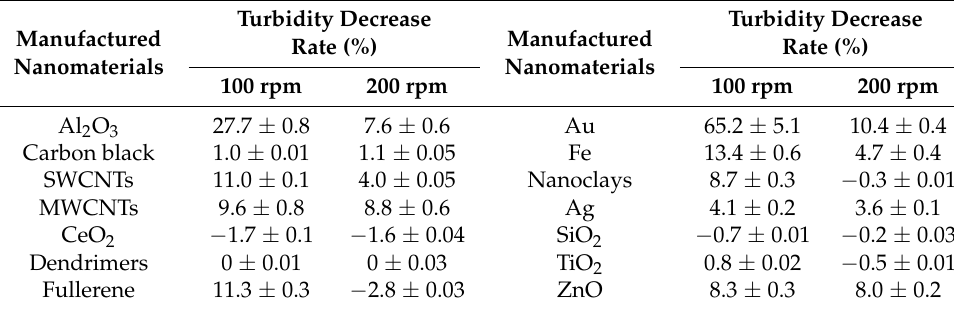
Table 3. Turbidity decrease rate of manufactured nanomaterials in 72